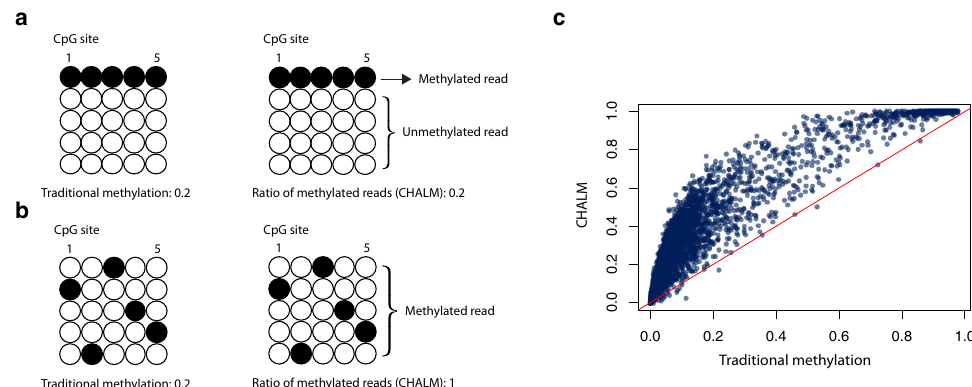
Fig. 1 CHALM quanti fi es cell heterogeneity – adjusted DNA methylation level. a , b show two different methylation patterns of a promoter region that cannot be distinguished by the traditional method. c Scatter plot shows a comparison of the methylation level calculated by the traditional and CHALM methods for the promoter CGIs of CD3 primary